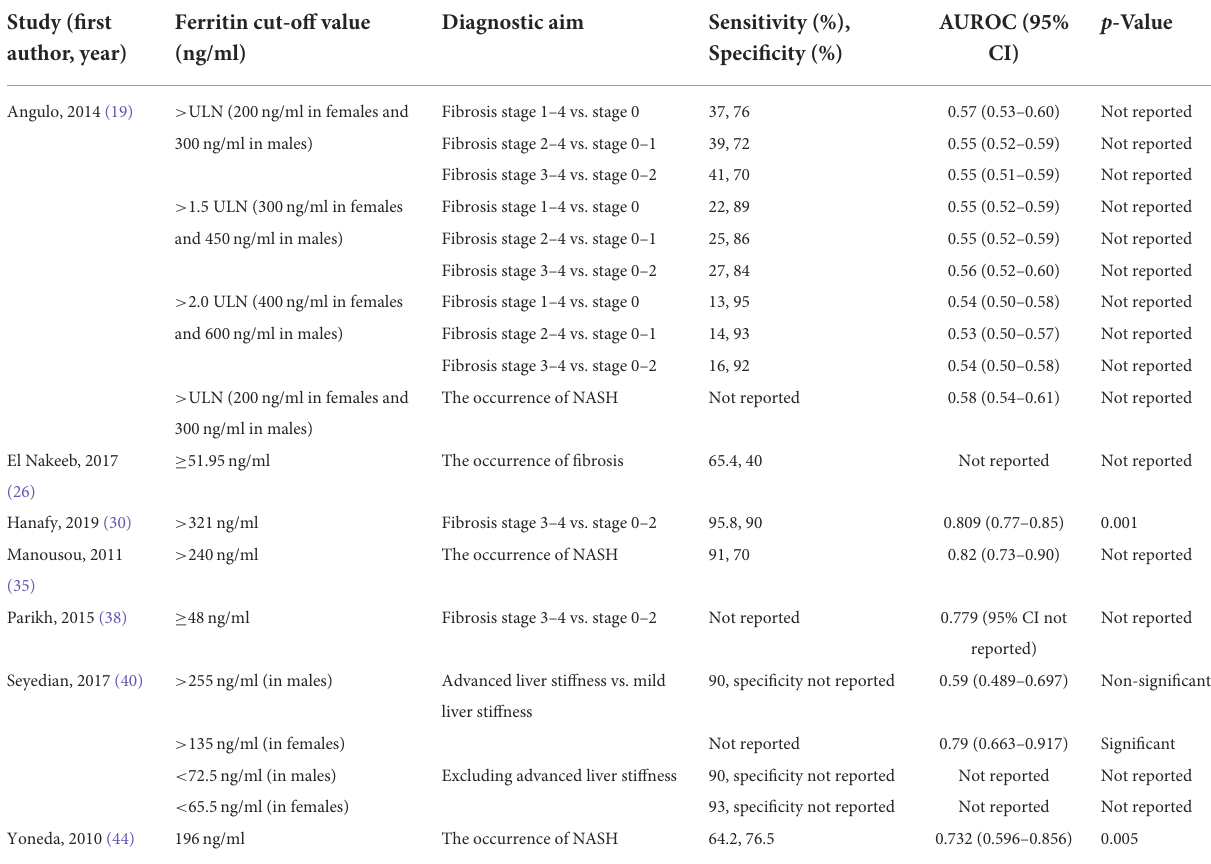
TABLE 2 Summary of receiver operating characteristic (ROC) curve analysis of included